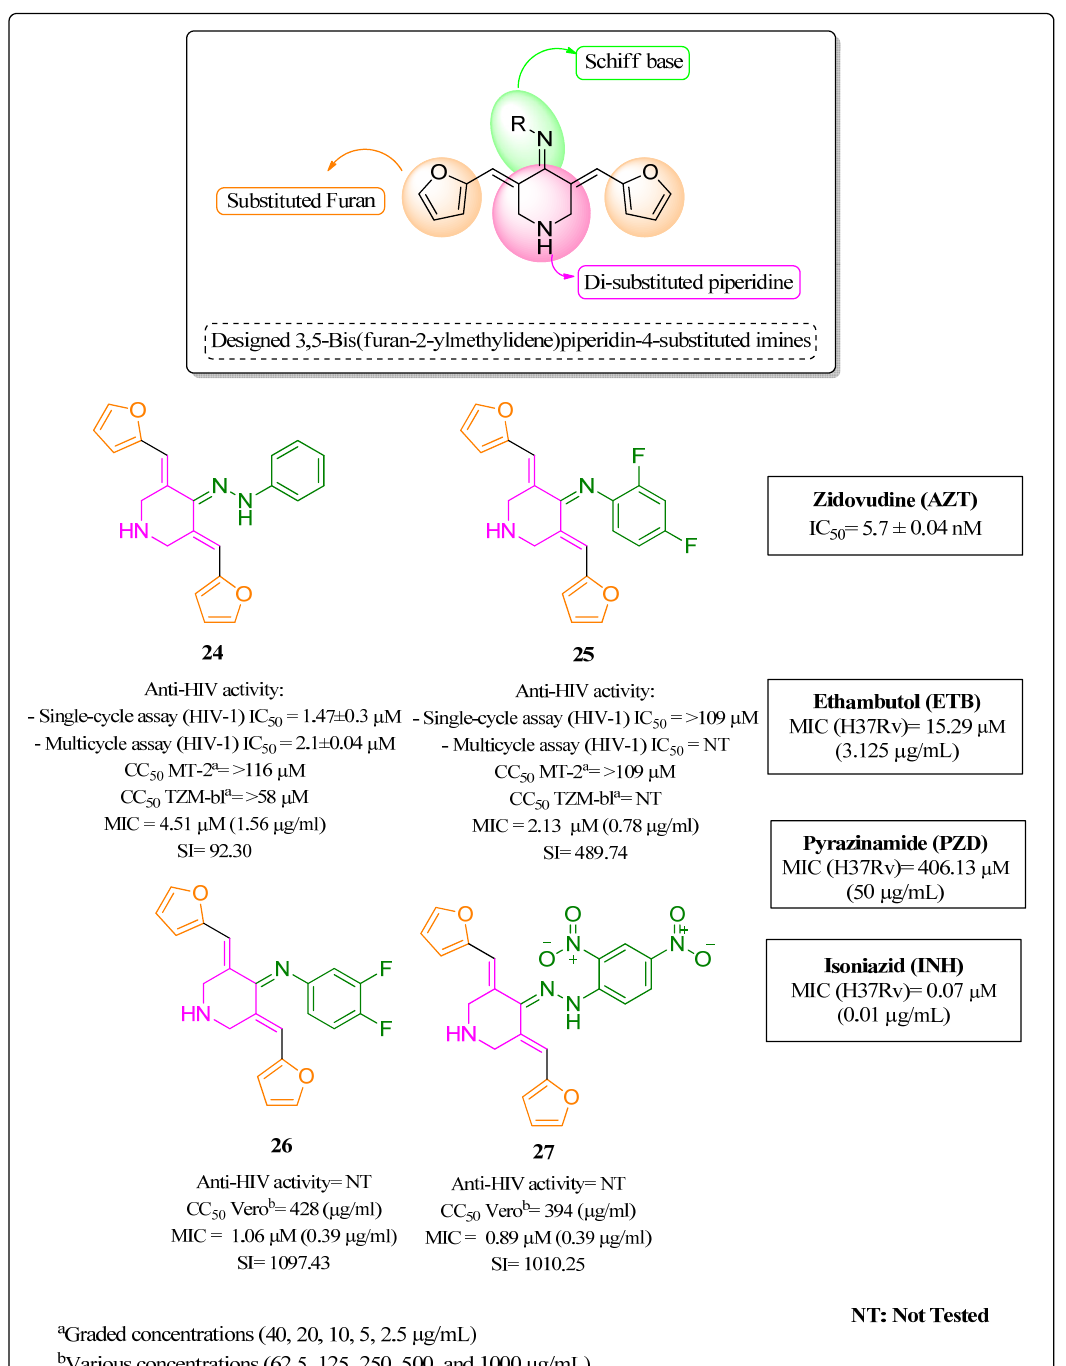
Figure 21. Anti-HIV and anti-MTB activities, as well as cytotoxicity studies, of 3,5-bis(furan-2-ylme-thylidene)-piperidin-4-substituted imines derivatives 24–27 [105].